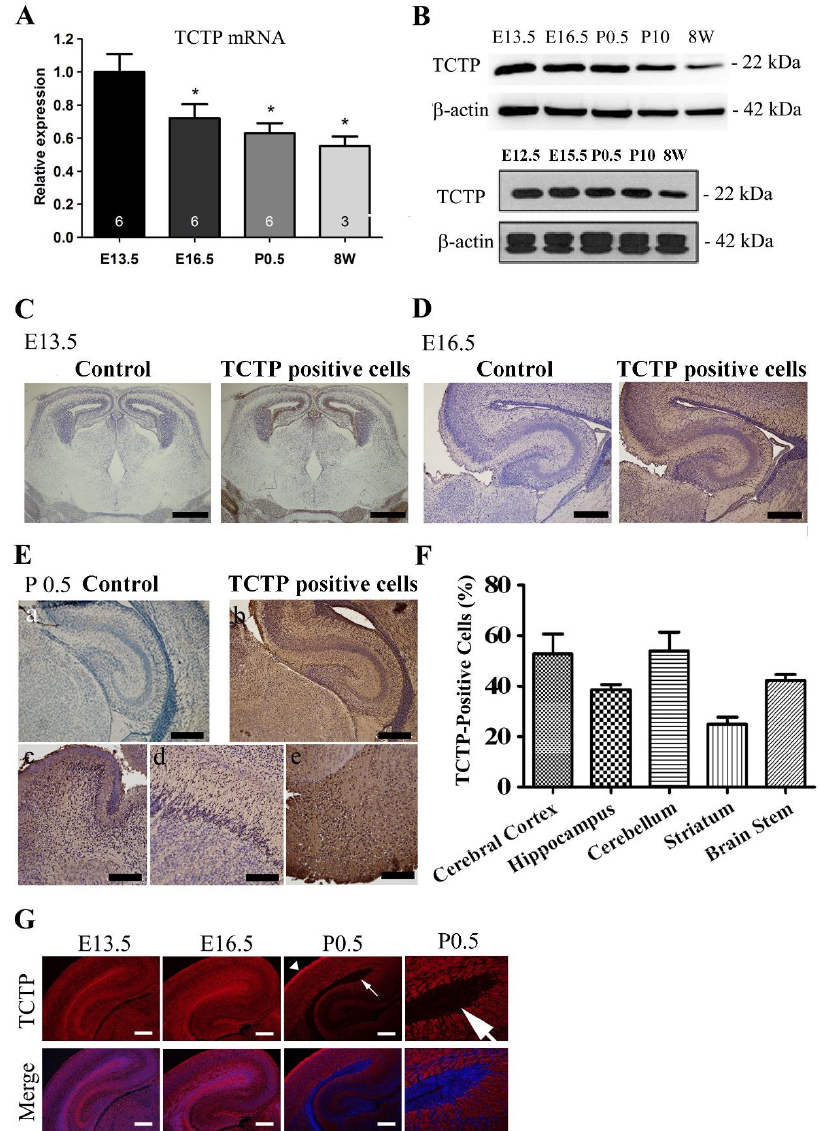
Figure 1. Expression pattern of translationally controlled tumor-associated protein (TCTP) from the embryonic to adult stage in the brain. ( A ) Relative TCTP mRNA expression at different stages in whole brain from wild-type mice was estimated by qRT-PCR (data presented as mean ± SEM, * p < 0.05 compared with embryonic day 13.5 (E13.5), one-way ANOVA, n = 3–6 per group). ( B ) TCTP protein in the whole brain from control mice ( TCTP flox / flox ) at E12.5, 13.5, E15.5, 16.5, and postnatal day 0.5, 10, and 56 was estimated by Western blotting. ( C – E ) TCTP protein expression pattern in whole- brain sagittal sections from wild-type mice at E13.5 and coronal sections at E16.5 and P0.5, including the (a) cerebral cortex, (b) hippocampus, (c) cerebellum, (d) striatum, and (e) brain stem, detected by immunohistochemistry with DAB staining (brown stain indicates TCTP-positive cells) ( n = 3 for each time point). ( F ) Summarized quantification of TCTP protein expression in ( E ). ( G ) Representative